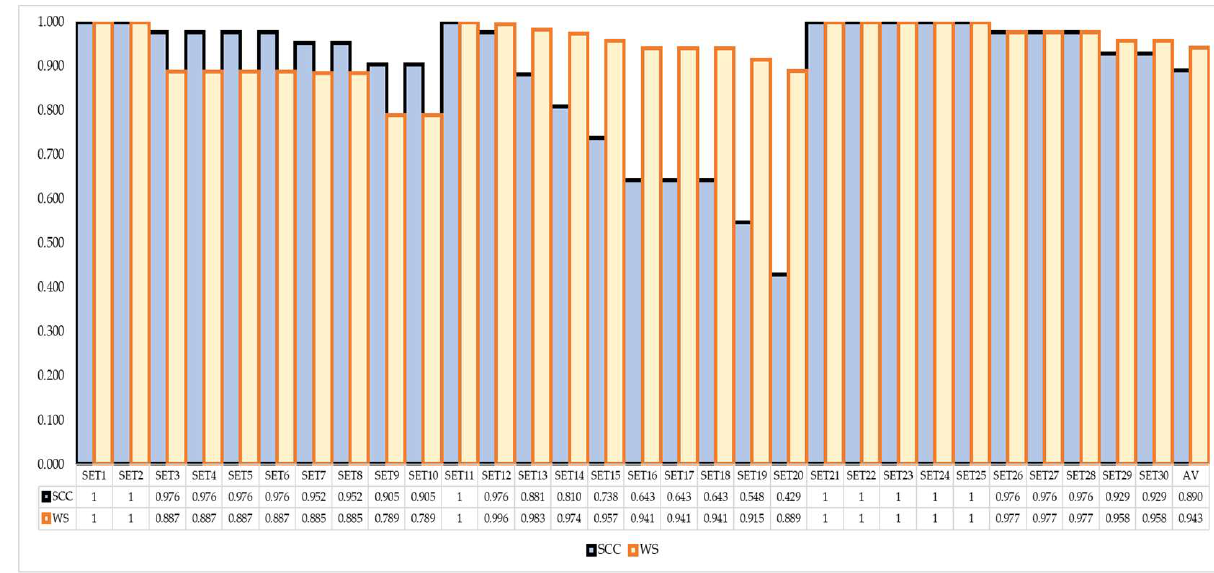
Figure 11. SCC and WS values for 30 newly formed scenarios for both companies.